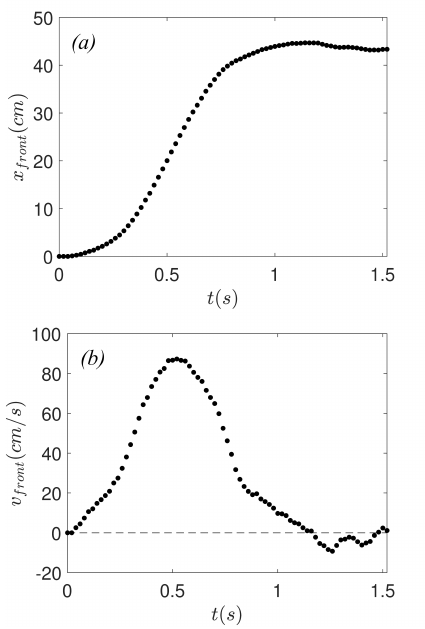
Figure 4. Time evolution of (a) the position, x front ( t ), and (b) the velocity v front = d x front / d t of the granular front for H 0 = 19 cm, L 0 = 10 cm and h 0 = 25 cm (regime I, for Fr 0 = 0 . 87 and Fr f = 0 . 18).